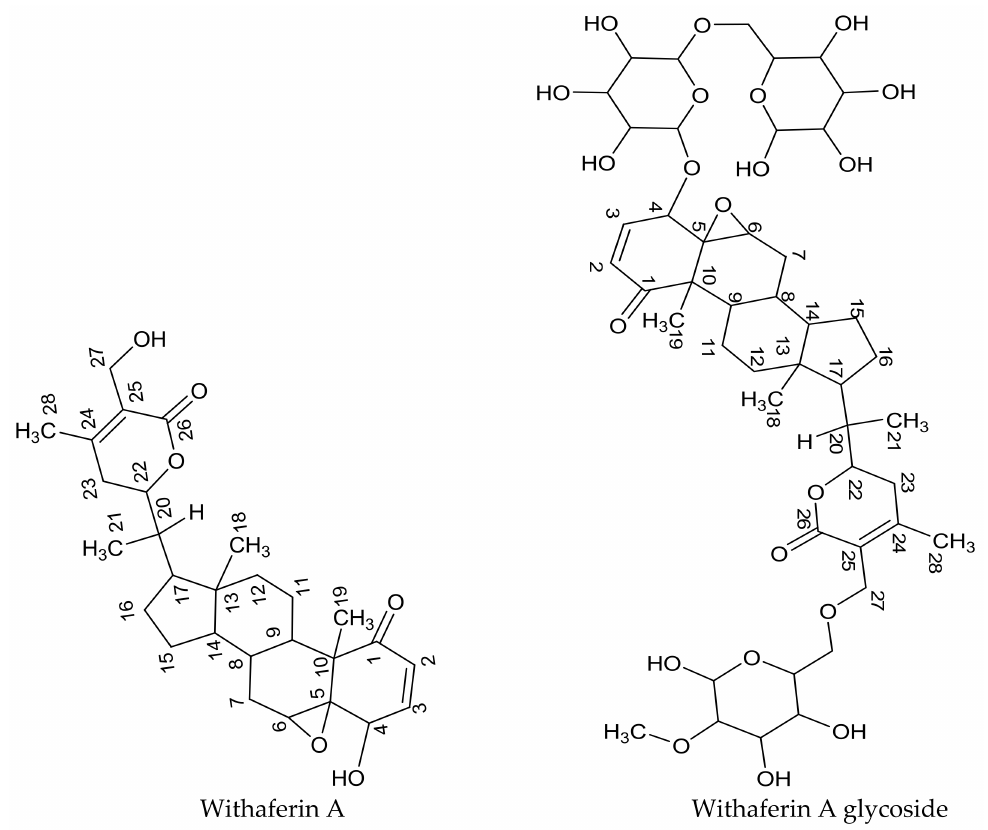
Figure 5. The structure of withaferin A and the withanolide glycoside compound isolated from the W. somnifera leaf ethyl acetate